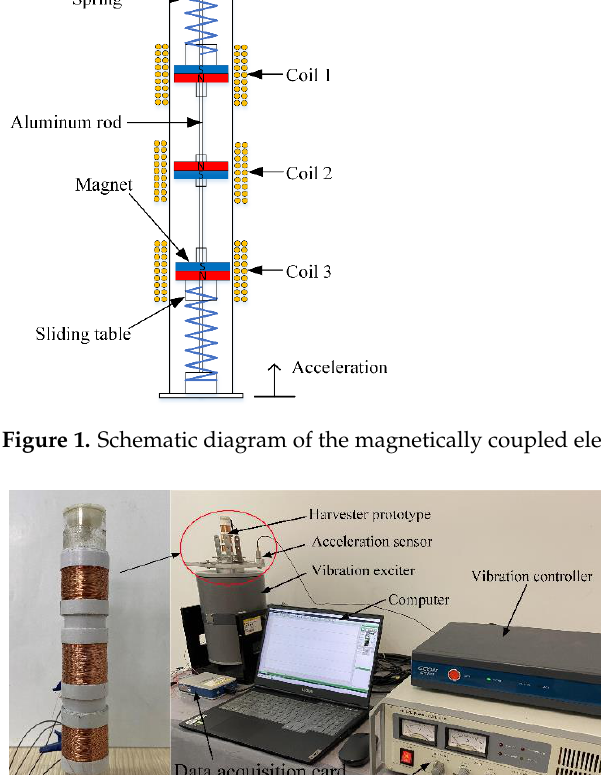
Figure 2. Experimental platform and data acquisition system. 3. Results and Discussion 3.1. Electrical Output under Harmonic Excitations This section describes the output characteristics of the MCEEH under vibration exci- tation. Experimental investigation of the output characteristics of the MCEEH used the